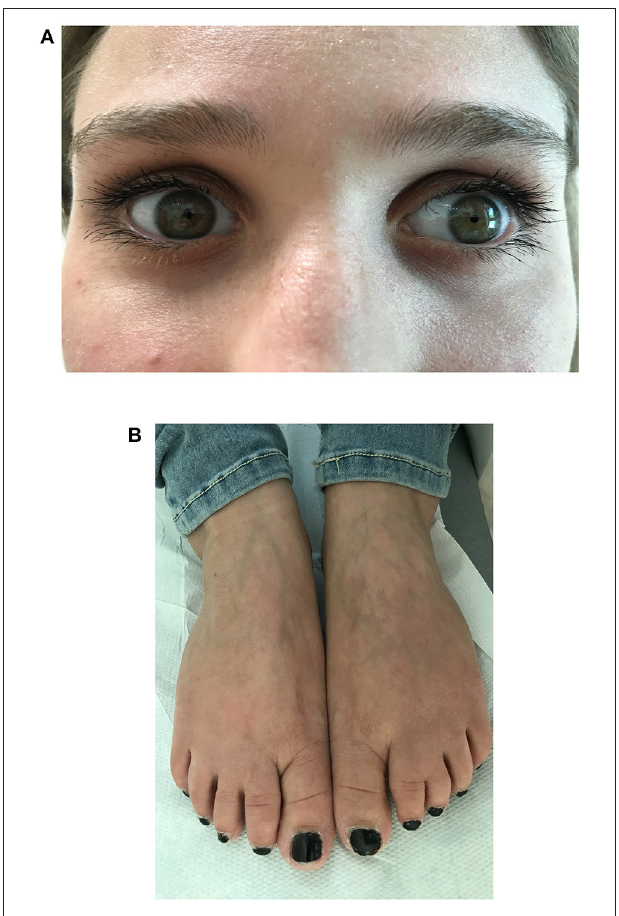
FIGURE 1 | Morphological and ophthalmological findings in a 21-year-old Italian female with Stormorken syndrome. (A) Close-up photo of the patient’s eyes showing bilateral and symmetric miosis. (B) Photo of the patient’s feet showing partial syndactyly of the second and third